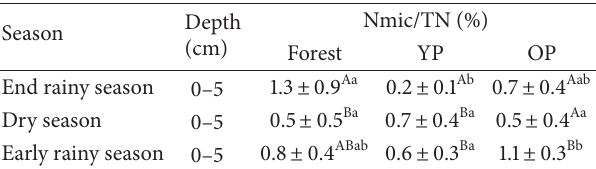
Table 5: Microbial nitrogen percentage in the total soil nitrogen in forest and